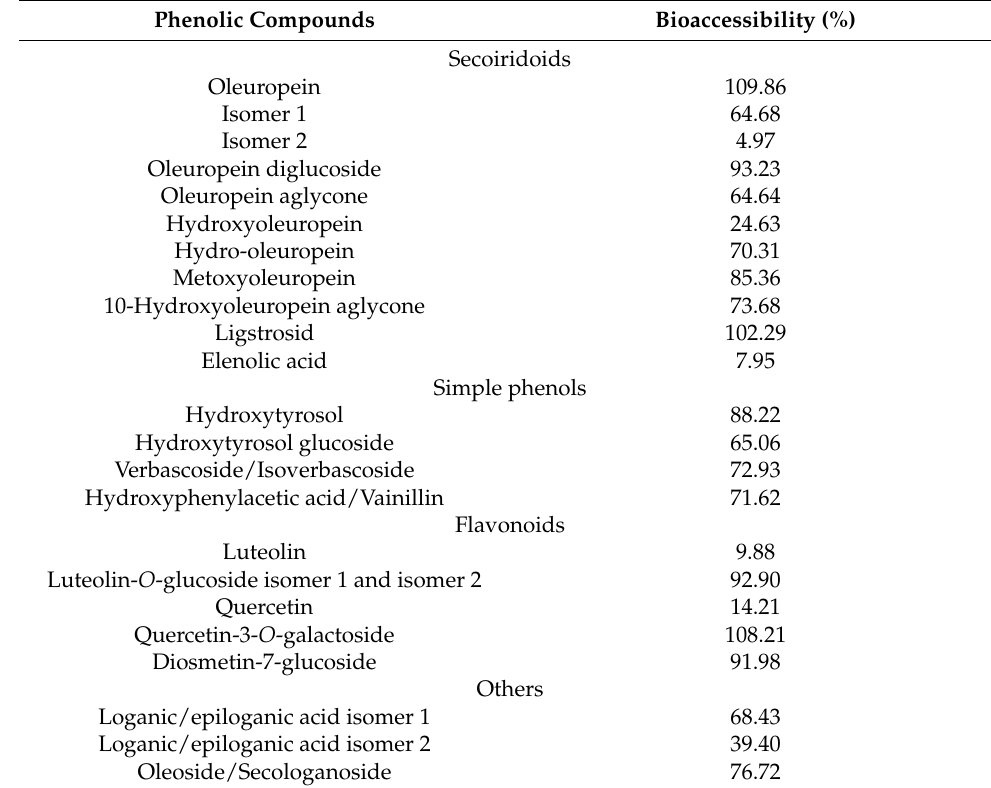
Table 3. Bioaccessibility percentage for the quantified phenolic